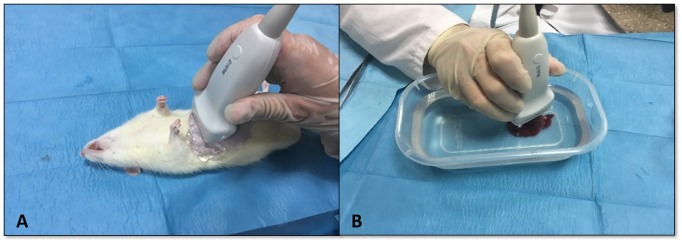
A, In vivo ultrasound study with the animal placed in decubitus. B, Ex vivo ultrasound study using the immersion technique.